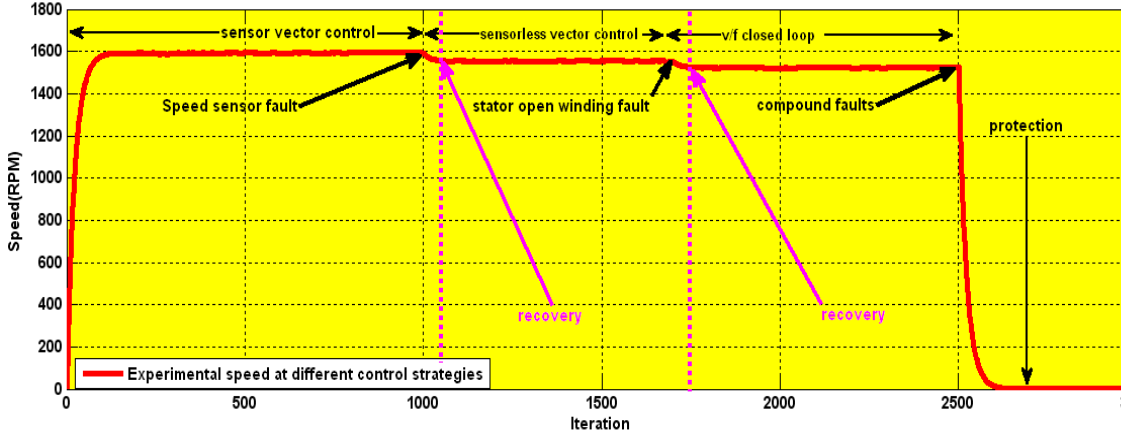
Figure 25. Experimental speed transition with different